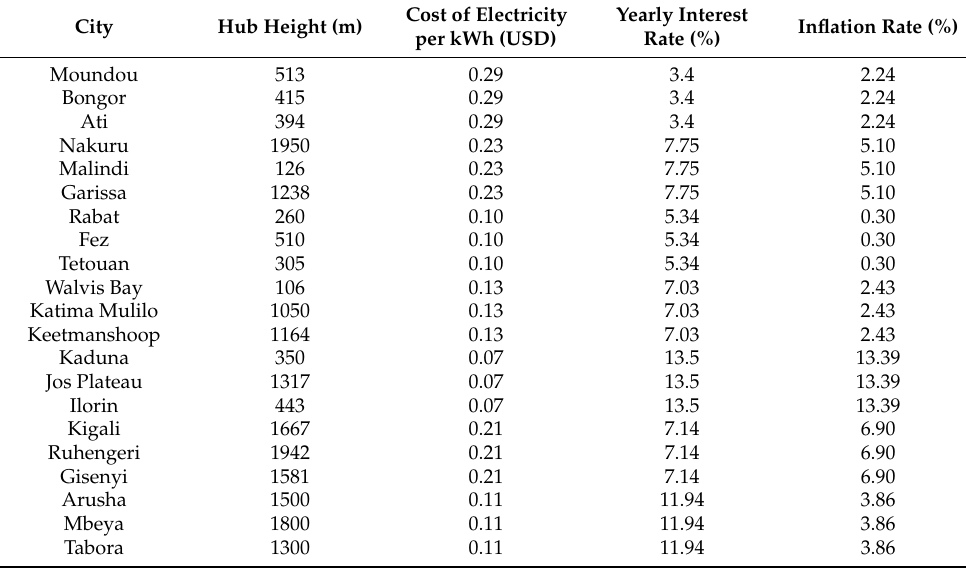
Table 3. Location dependent variables